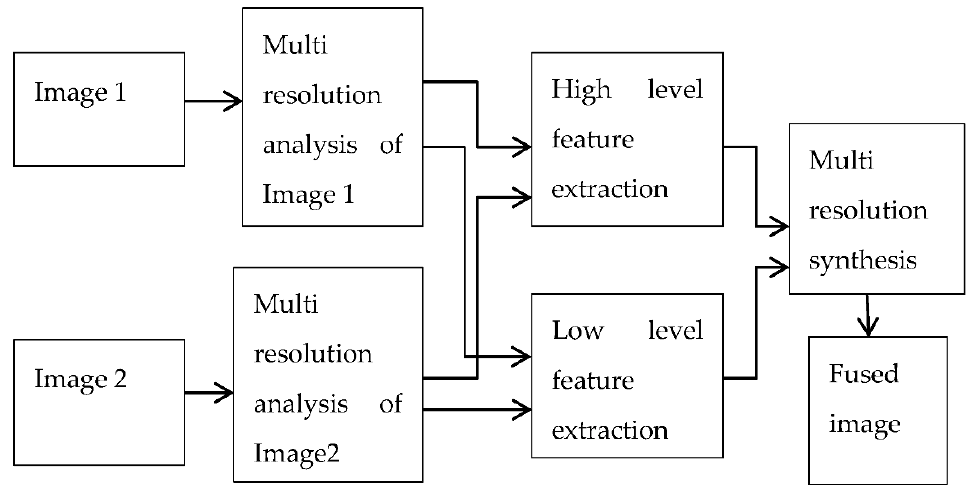
Figure 2. Image fusion block diagram.